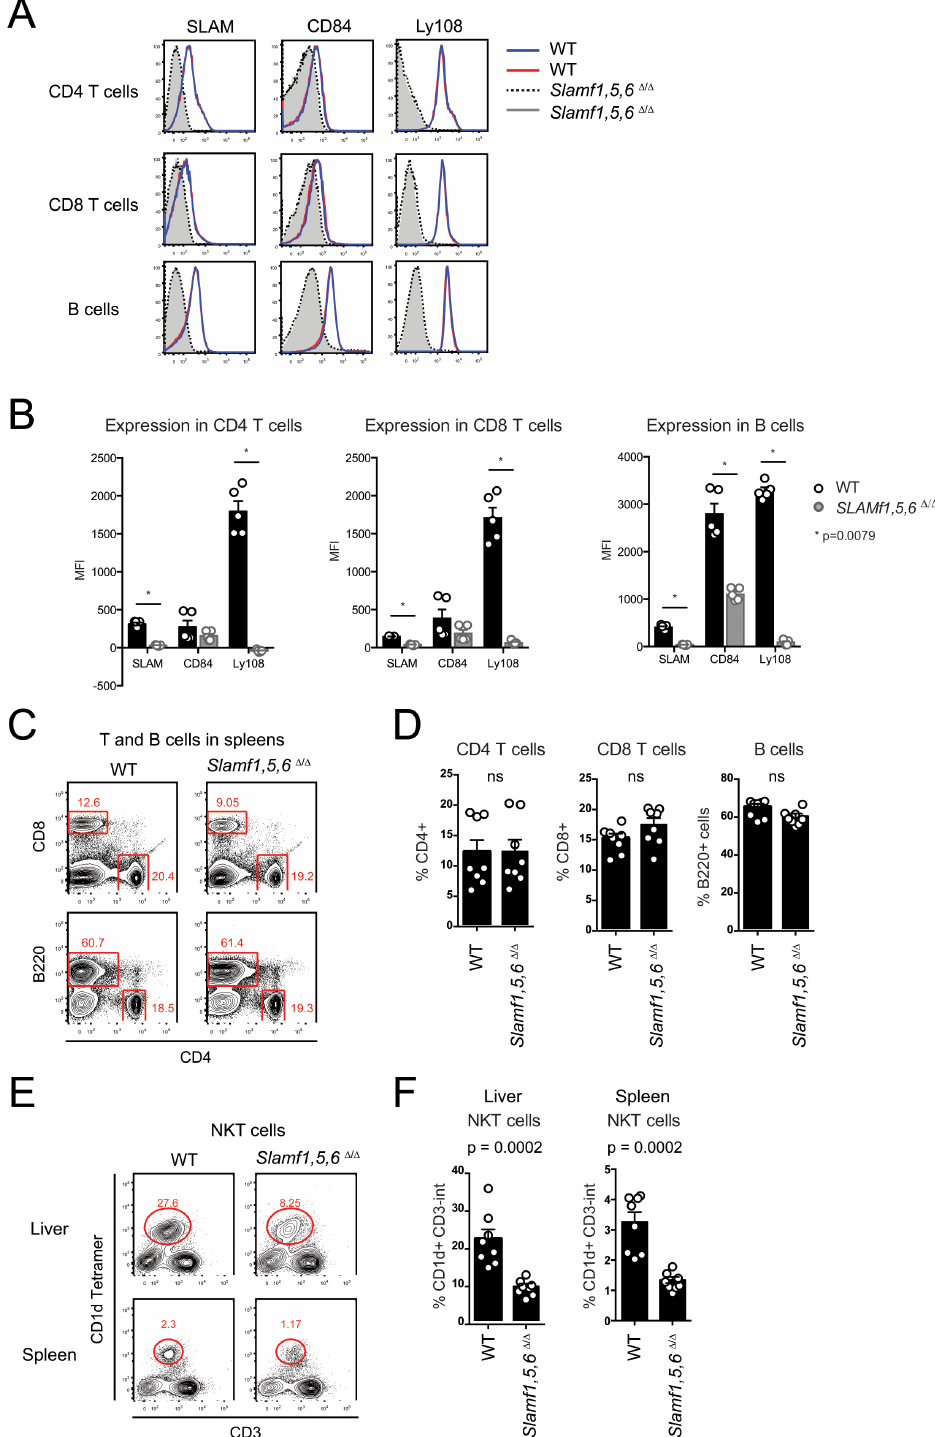
Fig 2. Slamf1 , 5 , 6 Δ / Δ mice exhibit deficiencies in NKT cell development but no overt defects in CD4 T cell, CD8 T cell, or B cell development. (A) Surface expression and (B) MFI of SLAM, CD84, and Ly108 on peripheral CD4 T cells, CD8 T cells, and B cells from WT and SLAMf receptor triple gene disruption mice. (A-B) Two independent experiments are shown, with 2 – 3 mice per group. (C) Flow cytometry plots and (D) graphs of CD4 + T cell, CD8 + T cell, and B220 + B cell frequencies in spleens of WT and SLAMf receptor